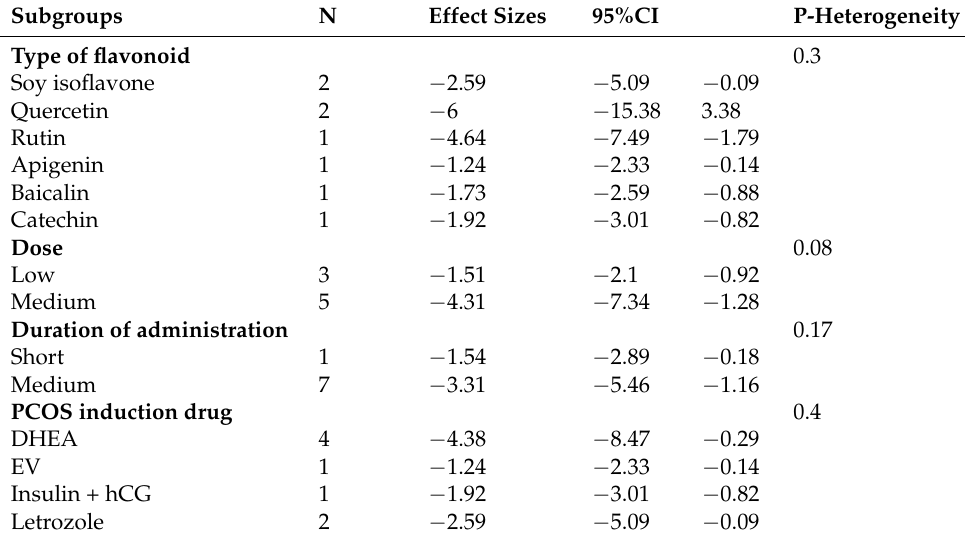
Table 5. Subgroup analysis of flavonoids effect on LH/FSH.